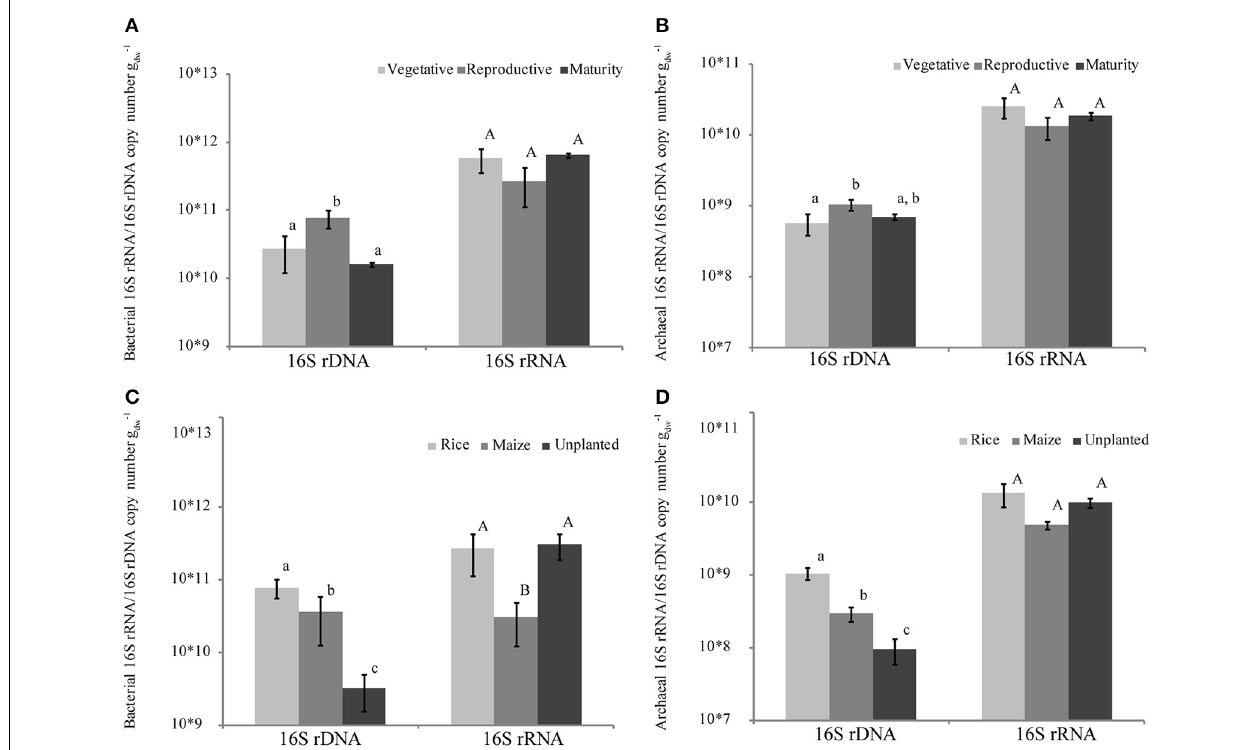
FIGURE 1 | Ribosomal 16S rDNA and rRNA copy numbers quantified using qPCR. Abundance of bacterial 16S rDNA and rRNA (A,C) and archaeal 16S rDNA and rRNA (B,D) in rice fields at different plant growth stages (A,B)